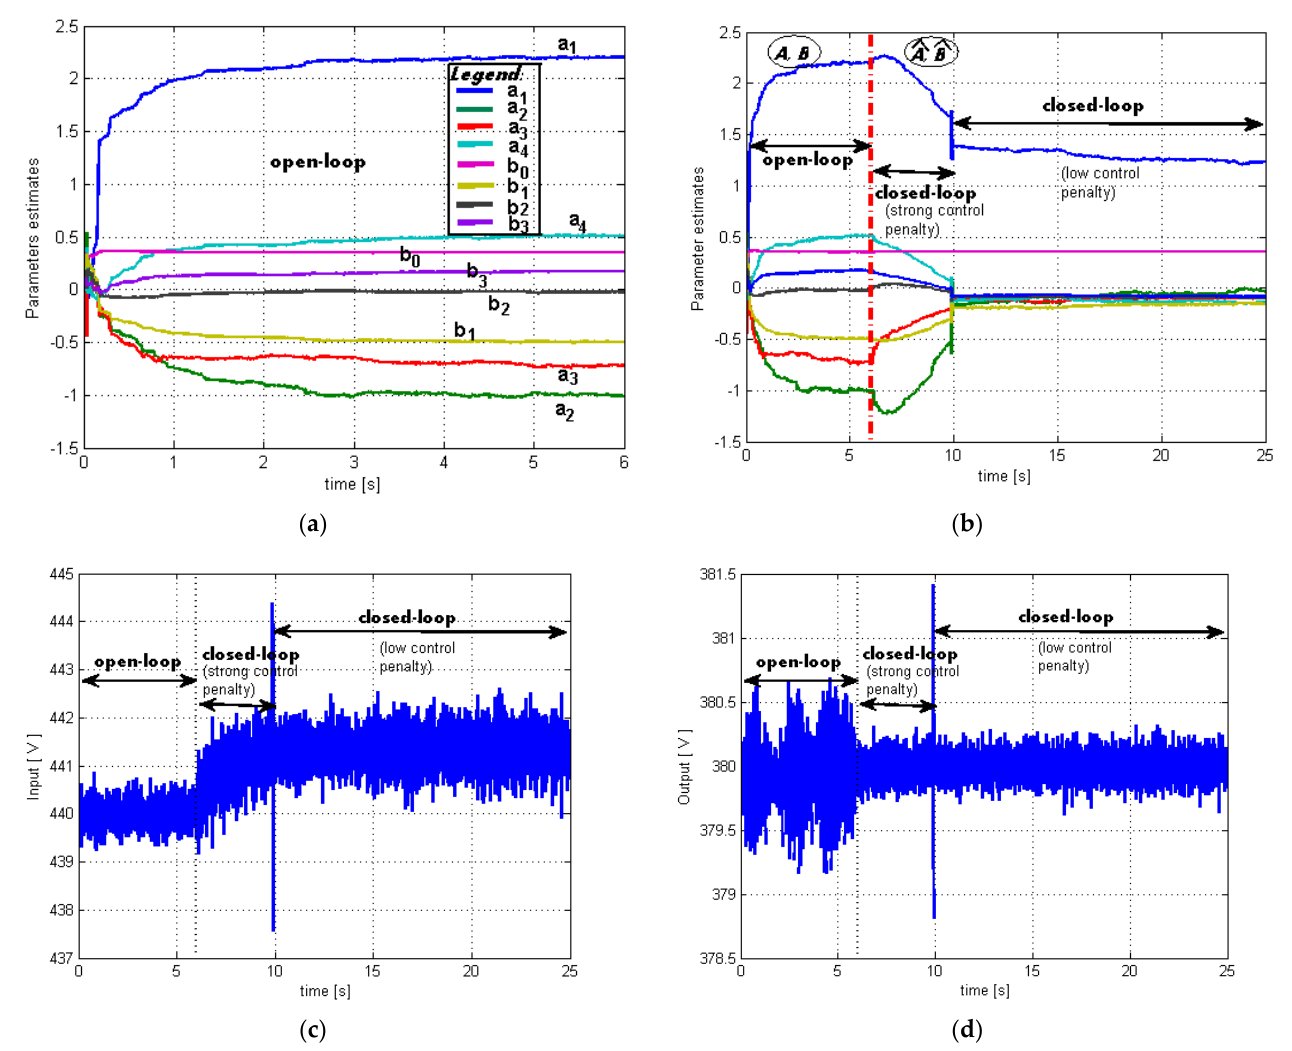
Figure 2. ( a ) Open-loop process parameters estimates (polynomials A ( z − 1 ) and B ( z − 1 ) ); ( b ) open-loop and closed-loop process parameters estimates (polynomials A ( z − 1 ) , B ( z − 1 ) in open-loop, ˆ A ( z − 1 ) , ˆ B ( z − 1 ) in closed-loop); ( c ) controller output (excitation voltage); ( d ) controlled output (terminal